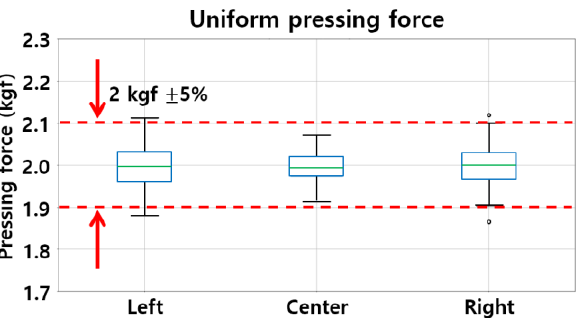
Figure 13. Force distribution experiment results along rollers using regression analysis results.